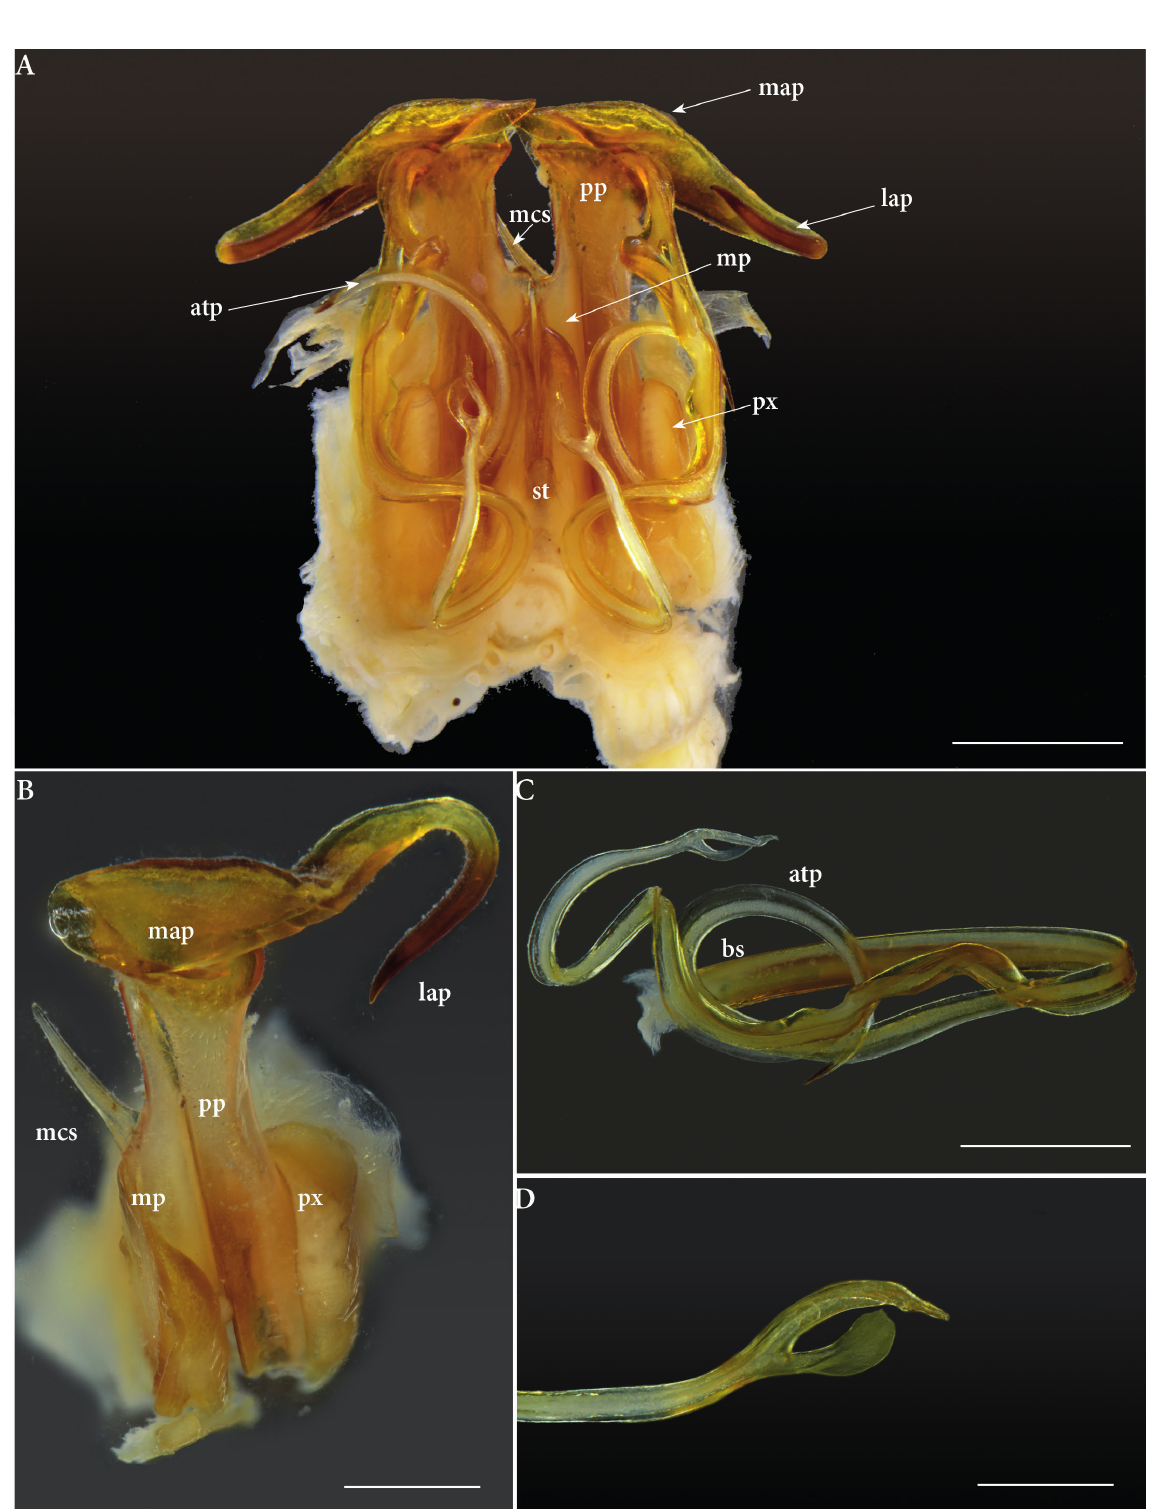
Fig. 4. Attemsostreptus reflexus sp. nov., male holotype (NHMD607065), gonopods. A . Gonopods, anterior view. B . Right gonopod, antero-apical view. C. Telopodite. D. Tip of telopodite. For abbreviations, see Material and methods. Scale bars: A = 1 mm; B–D = 0.5